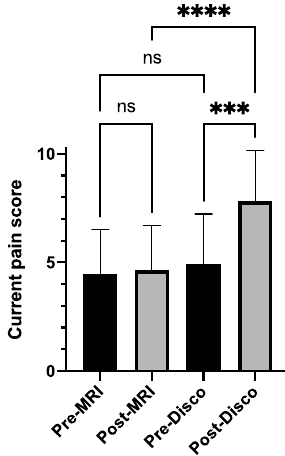
Figure 2. Pain scores. Pain scores were assessed by questionnaires before and after MRI and PD. Mean pain scores for Pre-MRI, Post-MRI, Pre-Discogram (Pre-Disco), and Post-Discogram (Post-Disco) were 4.5, 4.6, 4.9, and 7.8 respectively. Scores were significantly higher post PD compared to pre-PD and post-MRI scans (*** p = 0.0001; **** p < 0.0001, n =